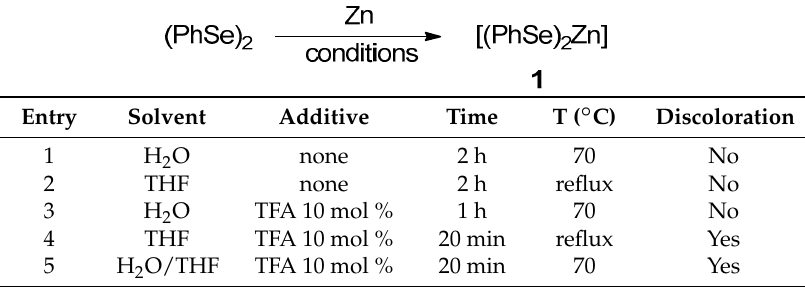
Table 1. Synthesis of compound 1 .